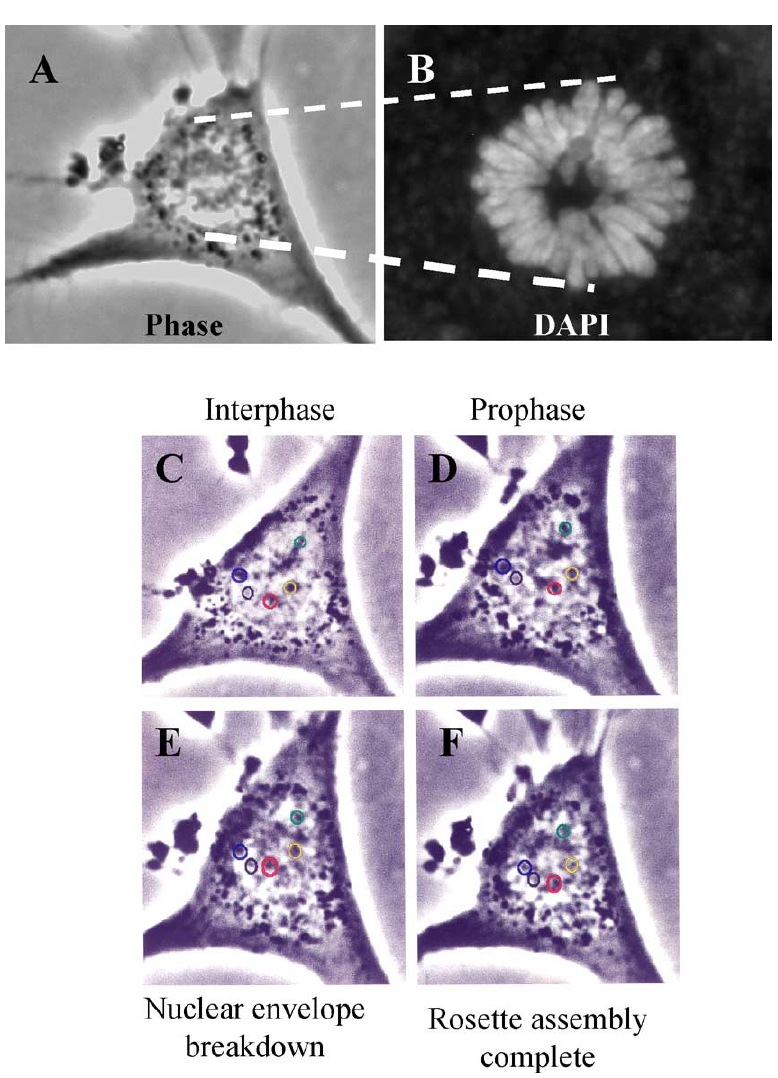
Fig. 1. (A) Phase-contrast micrograph of a normal human diploid fibroblast cell at the end of prometaphase. The cell is still somewhat flattened on the substratum, the nuclear envelope has recently disassembled and all chromosomes are arranged into a nearly planar, wheel-like chromosome rosette. (B) Staining of the chromosomes of the same cell shown in (A) with DAPI reveals the central hub of the rosette and the chromosome arms projecting radially from this hub. (C–D) Tracking of sequential movements of identified (color rings) centromeres within the nucleus of the same cell from S phase through completion of rosette assembly reveals that relative chromosome positions remain essentially unchanged during this